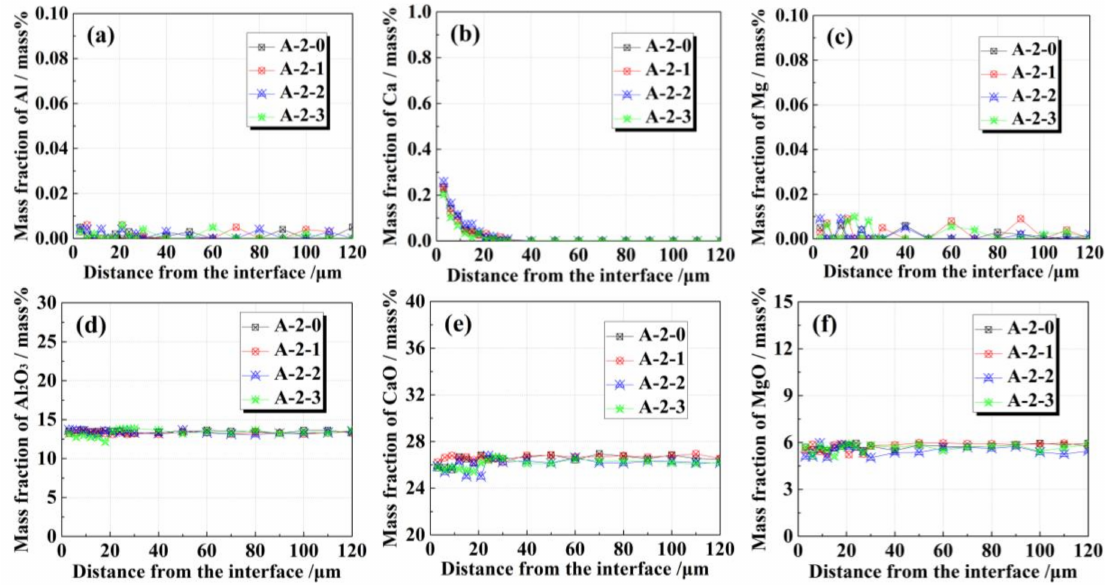
Figure 8. Compositional changes of the alloy and oxide near the interface in A-2- x diffusion couples after isothermal heating at 1473 K for 10 h: ( a ) Al; ( b ) Ca; ( c ) Mg; ( d ) Al 2 O 3 ; ( e ) CaO; ( f ) MgO.